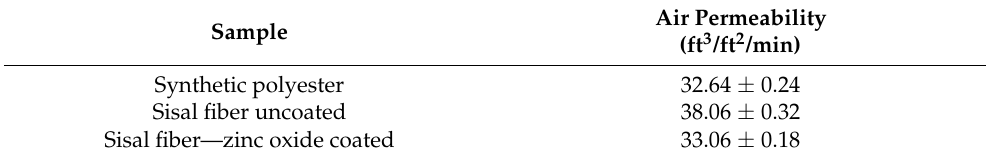
Table 1. Air permeability test